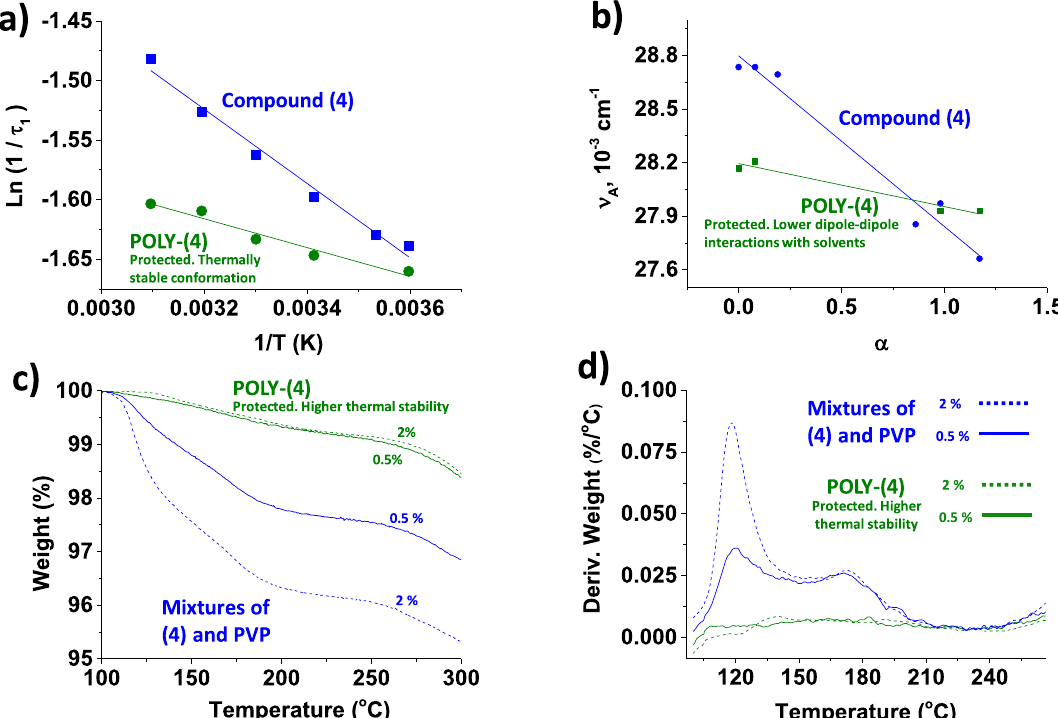
Figure 6. (a) Logarithm representation of an Arrehnius type plot for the reciprocal of τ1 with temperature for solutions of compound (4) and POLY- (4) in DMSO:H 2 O (10:90). (b) Solutions of POLY- (4) and compound (4) were prepared in different solvents (water, methanol, ethanol, acetonitrile, and acetone) and measured by UV–Vis spectroscopy. The wavenumber corresponding to the maximum absorbance of each spectrum is represented against the acidity component of each solvent (α). The greater slope, the more intensive dipole– dipole interactions of the chromogenic units with solvents (c) Thermograms and (d) derivative weight loss for POLY- (4) (green curves) and for mixtures of compound (4) with poly( N -vinylpyrrolidone) (blue curves), at molar ratios of the fluorescent units of 0.5 and 2 (solid and dashed, respectively). Heating rate 10 °C/min and nitrogen